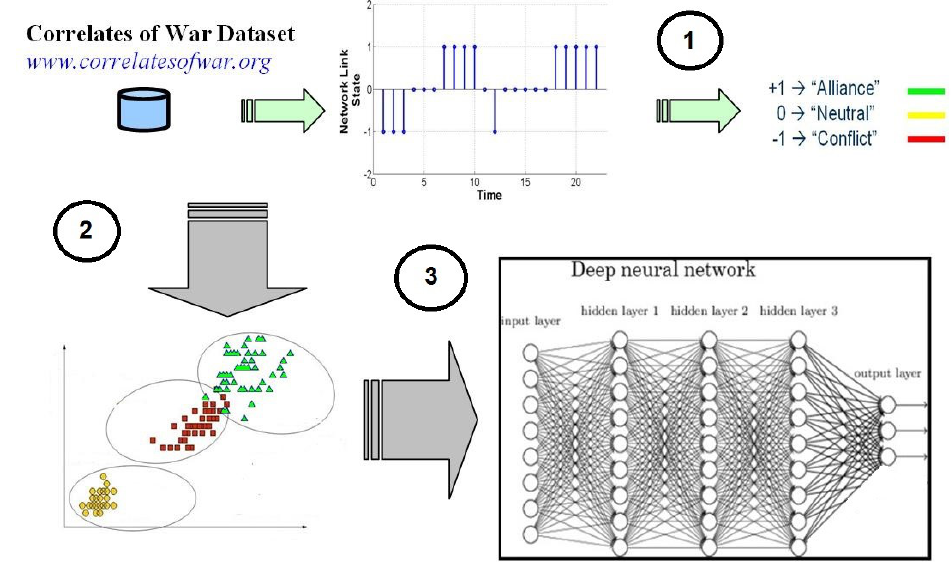
Figure 1. Schematic representation of the approach: Firstly, the link state prediction problem is re-casted in terms of a classification problem where the categories to discriminate are: Alliance , Neutral , and Conflict (point 1). Secondly, Geometric and Information-theoretic measures are used to characterize the complexity of the time series and the resulting classification dataset (point 2). Finally, Deep Learning Machines are used to learn the categories representing the state of network links (point 3).